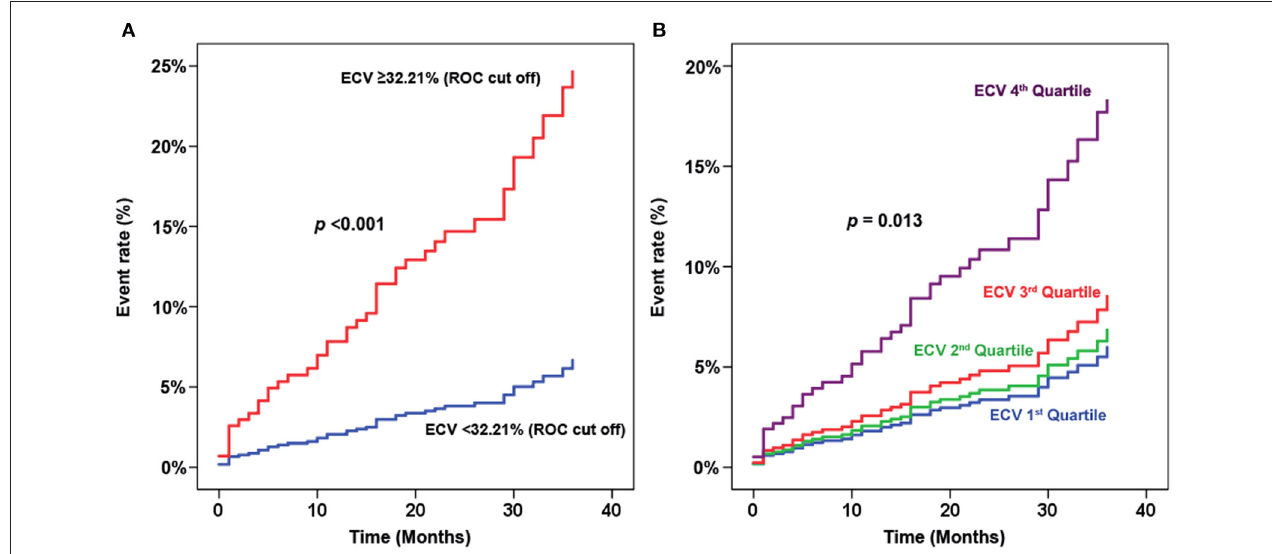
FIGURE 6 | Sensitivity analysis of extracellular volume fraction (ECV) for predicting clinical outcomes. (A) Hazard graph of patients with ECV above and below the cut-off value derived from receiver operating characteristic (ROC) curve analysis. (B) Hazard graph of each quartile of